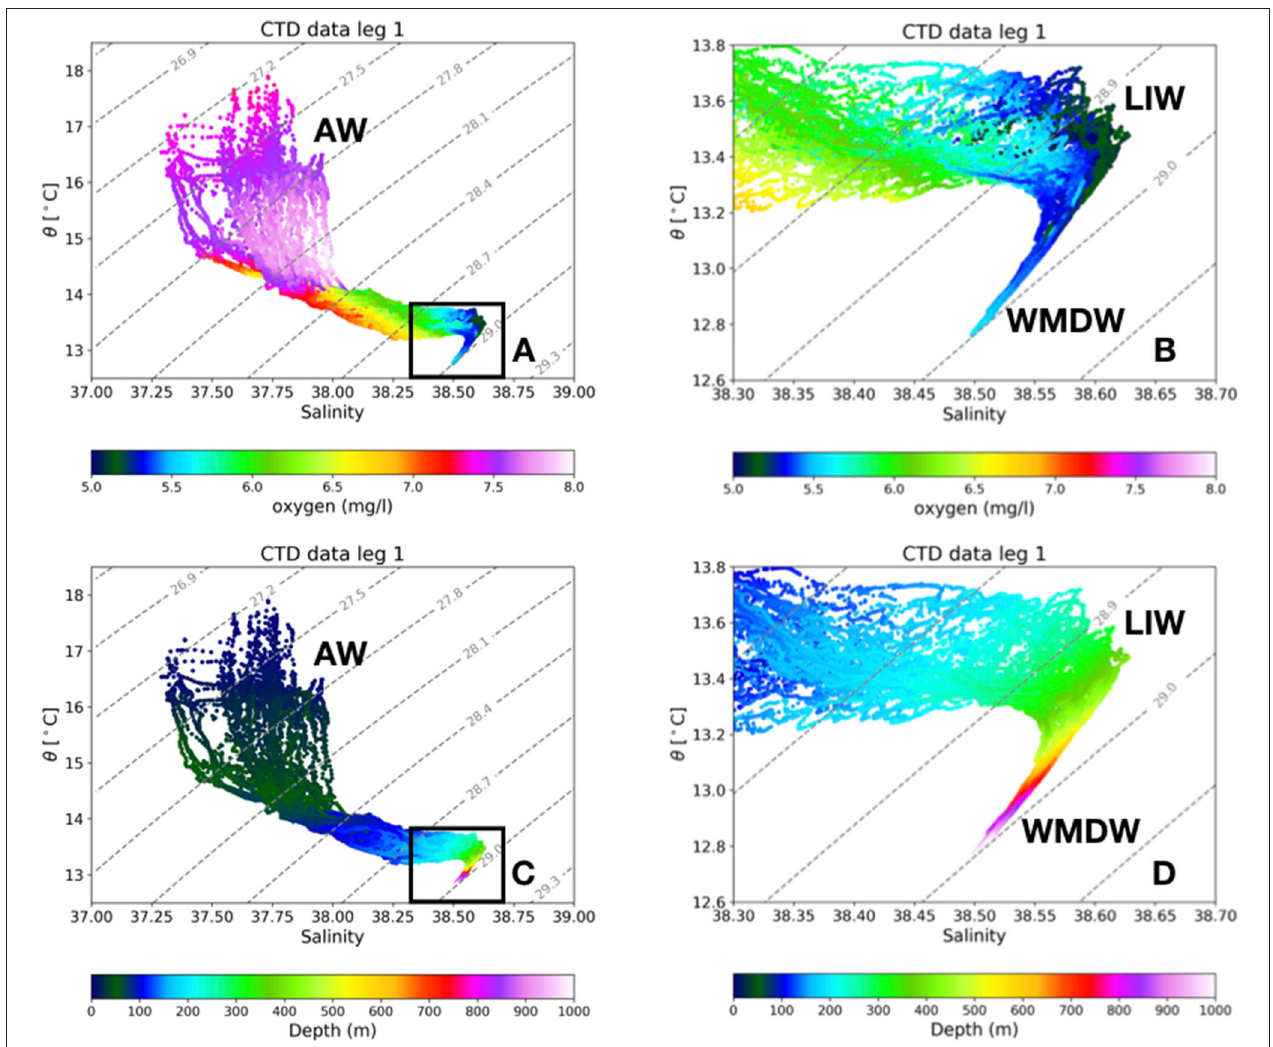
FIGURE 4 | (A–D) Temperature-salinity diagrams using data from Leg 1 CTD profiles. Color in top (bottom) plots represents the oxygen concentration (depth). The right column is a zoom of the left column. The presence of the following water masses is also indicated: Atlantic water (AW), Levantine Intermediate water (LIW), and Western Mediterranean Deep water